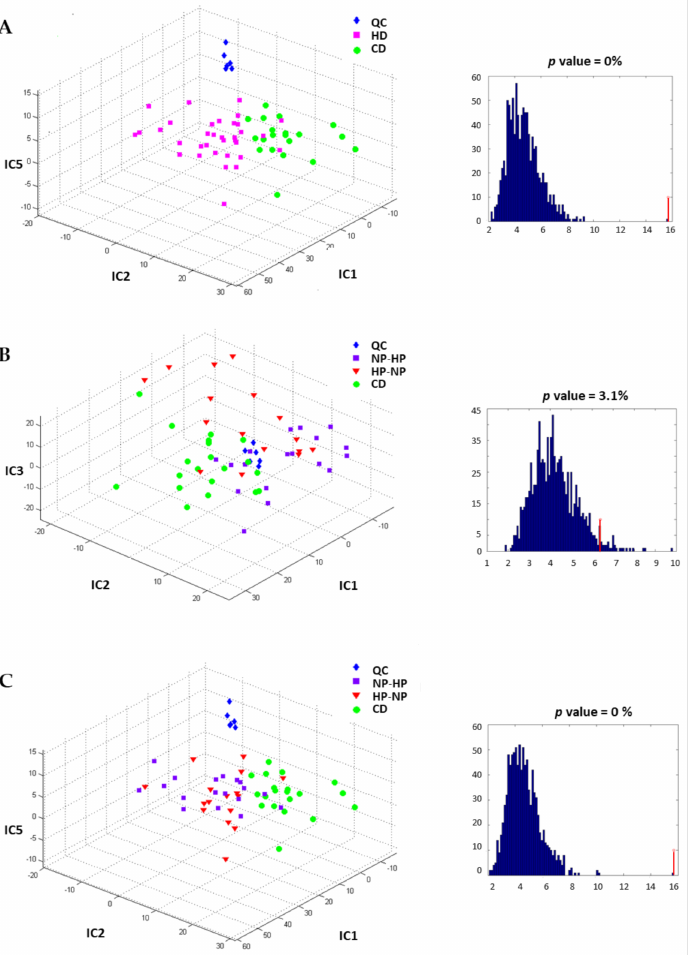
Figure 3. Independent components discriminant analysis proportions plot calculated after source signal extraction for the data obtained by RP chromatography and corresponding F-value associated with the Wilks’ lambda characterizing the discrimination of the predefined groups: ( A ) to discriminate the fat content of the diet. Separation of the HD groups from the CD-group based on IC1, IC2 and IC5; ( B ) to discriminate the protein content diet sequences, partial separation of the NP-HP group with HP-NP group based on IC1, IC2 and IC3; ( C ) to discriminate the diets, whatever the intervention period. Separation of the HP, NP and CD groups based on IC1, IC2 and IC5. CD: control diet; HD: high-fat, hypercaloric diet whatever the protein content of the diet; NP-HP: NPHD at P1 and HPHD P2 period; HP-NP: HPHD at P1 and NPHD P2 period; HP: HPHD at either P1 or P2 period; NP: NPHD at either P1 or P2 period; QC: quality